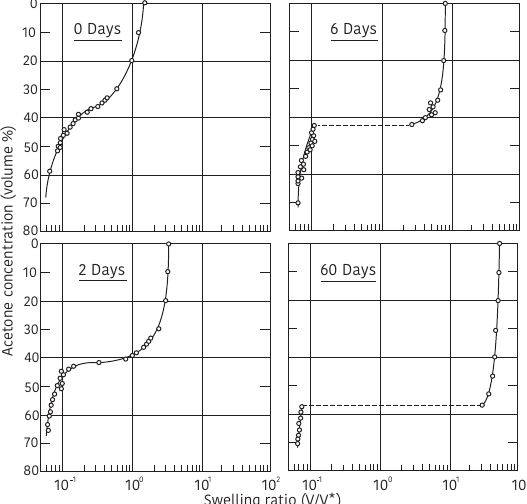
Figure 1. The volume phase transition of ionic poly(acrylamide) gels. The equilibrium swelling ratio of the gels in the mixed solvent system of water and acetone. The time of hydrolyzed reaction are given in the figure as, for instance, 6 Days. Reproduced with permission from Ref. [8]. © 1986, The Physical Society of